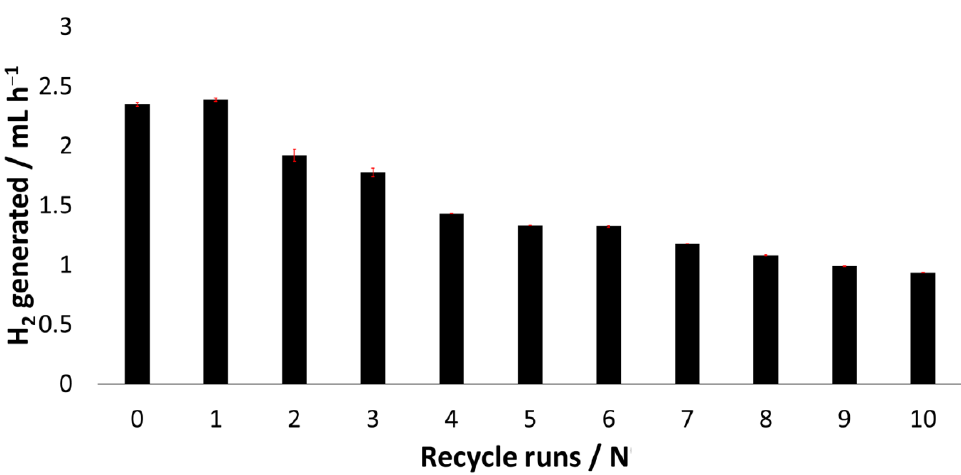
Figure 3. Graphical representation of dihydrogen generated measured through GC analysis after each cycle using rR@TiO 2 as photocatalyst, standard deviation indicated with red error bars.